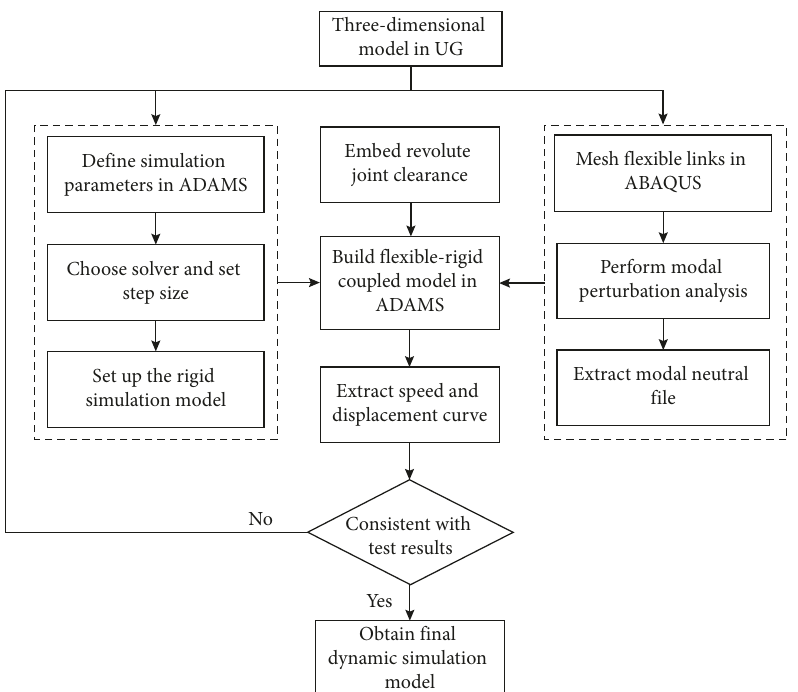
Figure 3: The modeling process of the operating mechanism.